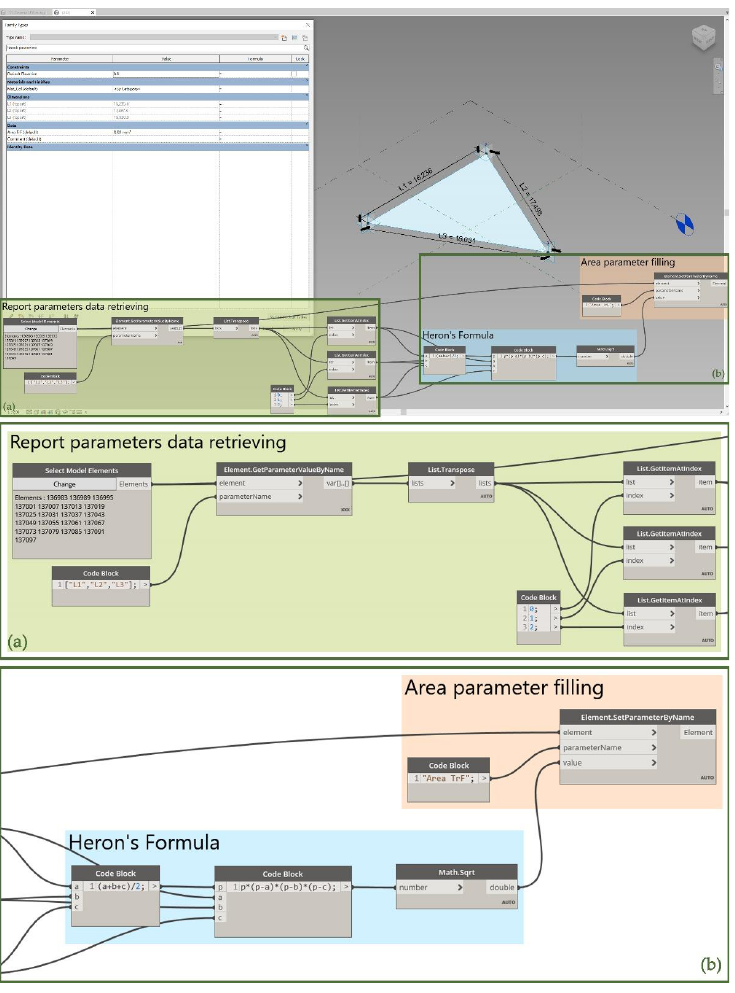
Figure 4. A daptive component, i.e., “Triangular Face.RFA”, in the Revit “Family Editor” and VPL s cript to calculate the triangle areas, once placed as “Family Instances”, via the “Heron’s Formula”.